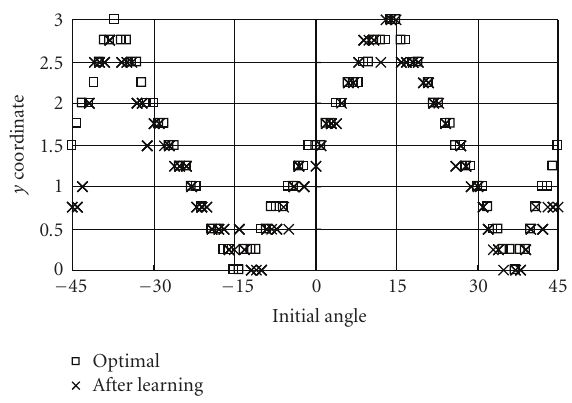
Figure 7: Positions where the agent catches the object when the initial object direction of motion varies (with no invisibility area).